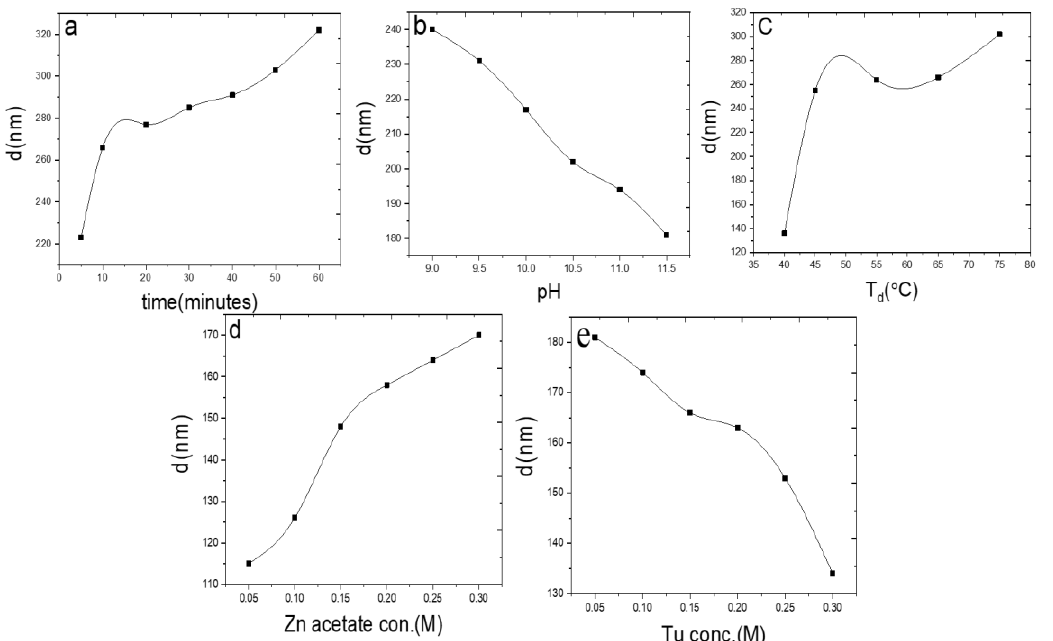
Figure 1. The thickness variation of ZnS thin film (where pH = 10, t = 10 min, T = 65 °C, zinc acetate and Tu-concentration = 0.2 M) as a function of different, ( a ) deposition time (t d ), ( b ) pH, ( c ) deposition temperature (T d ), ( d ) zinc acetate concentration, and ( e ) Tu-concentration.